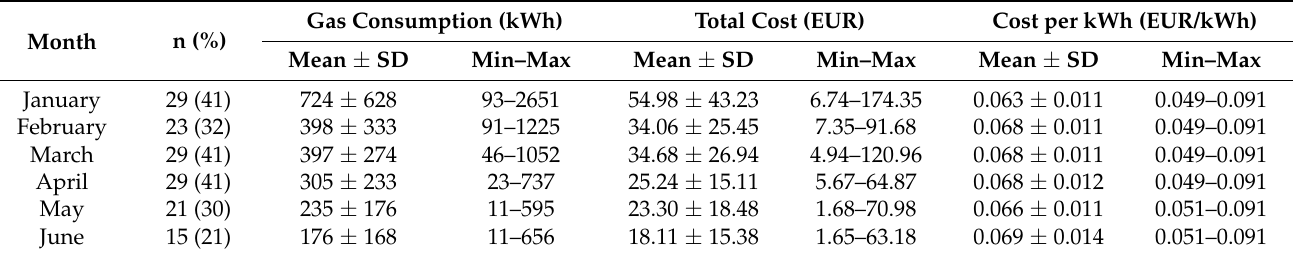
Table 3. Summary of the results collected through the participants’ gas